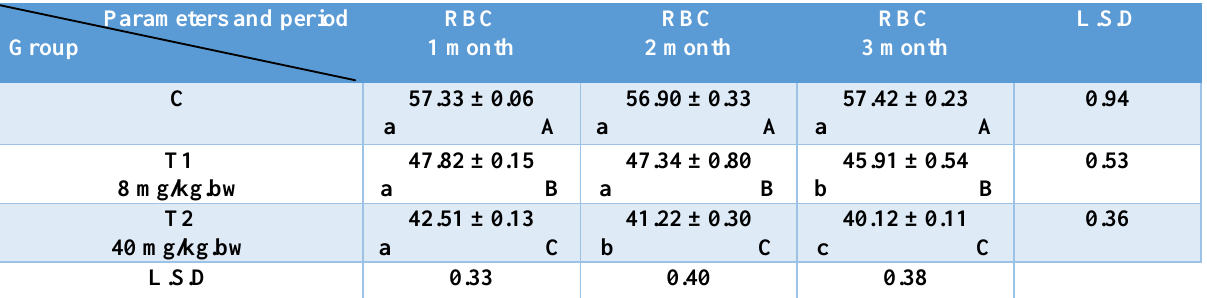
Table, 3: Values of RBC (Cells * 10³ /Cm³) in blood of rats treated with different doses of CuSO4.